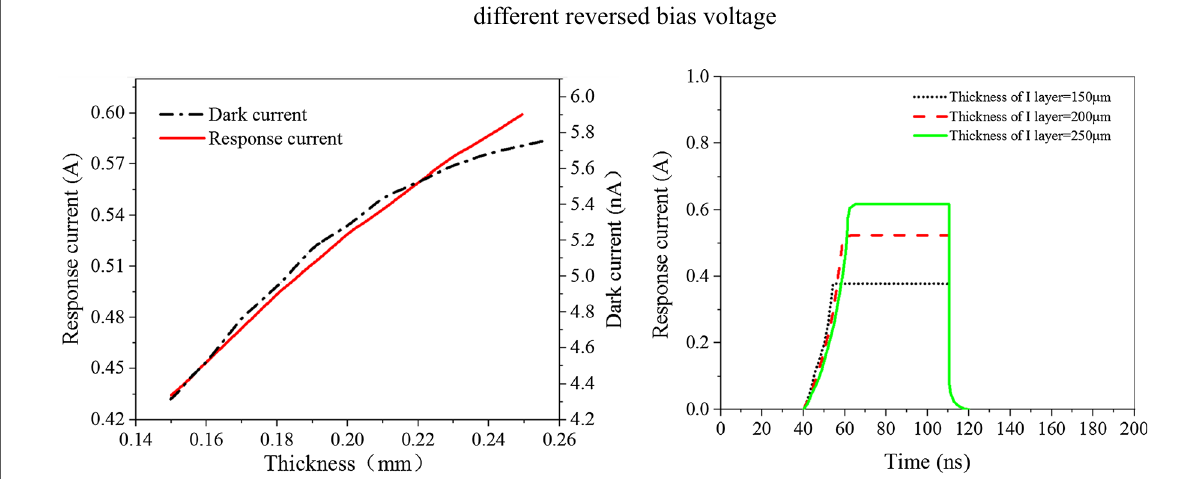
Fig. 4 The response current, dark current characteristic and rising time change curve of photodetector at different thickness of layer